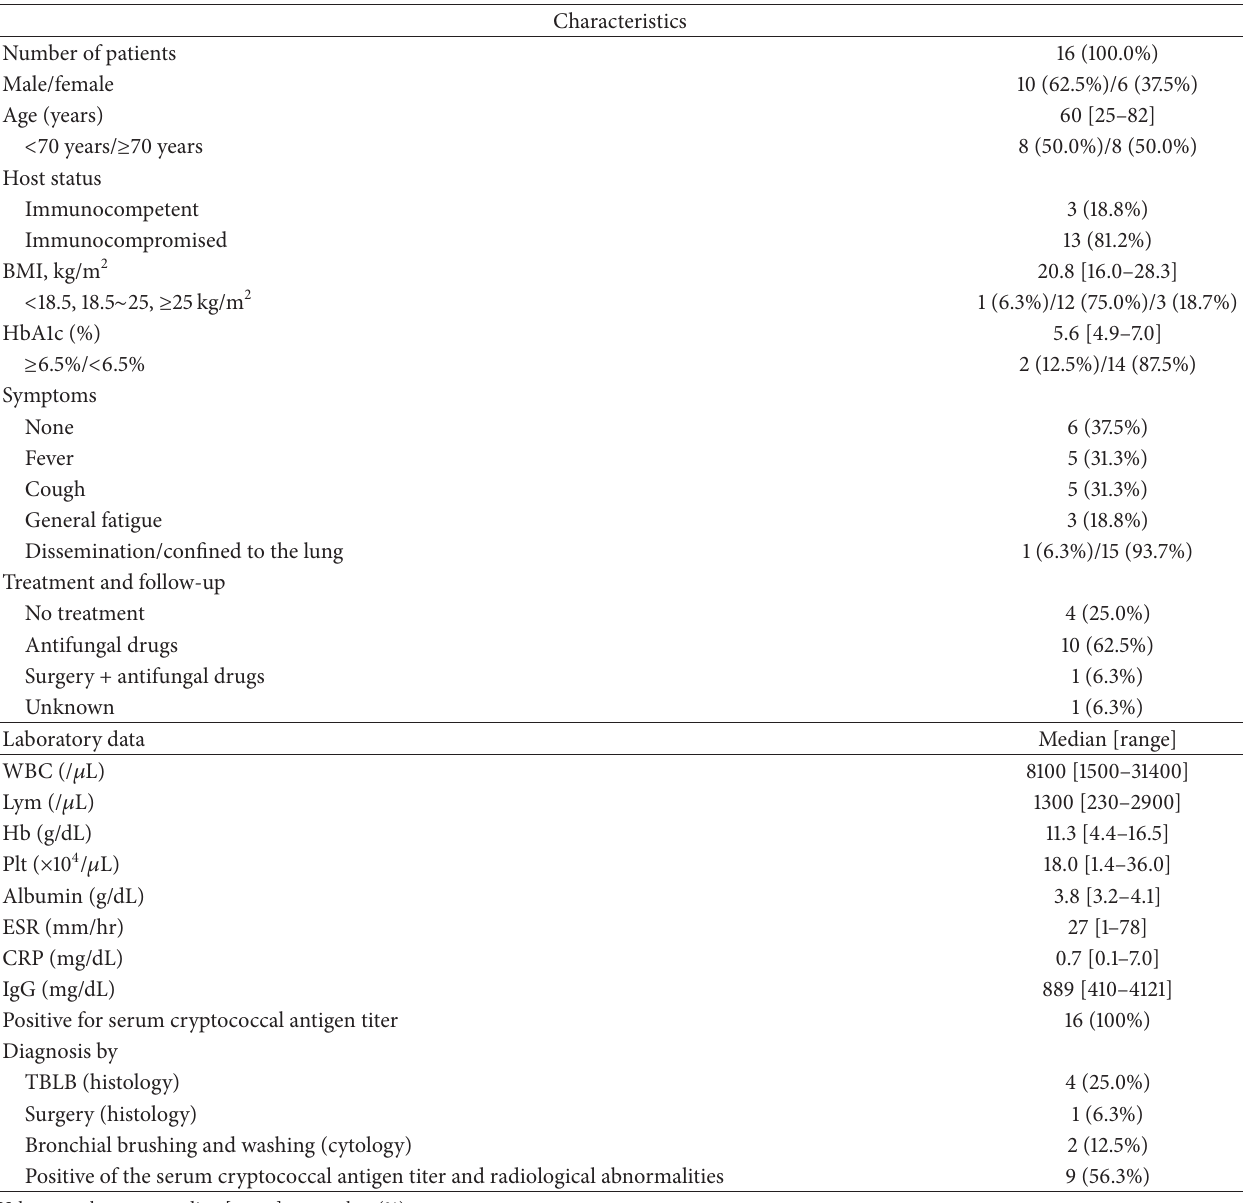
Table 1: Clinical characteristics of 16 patients with pulmonary